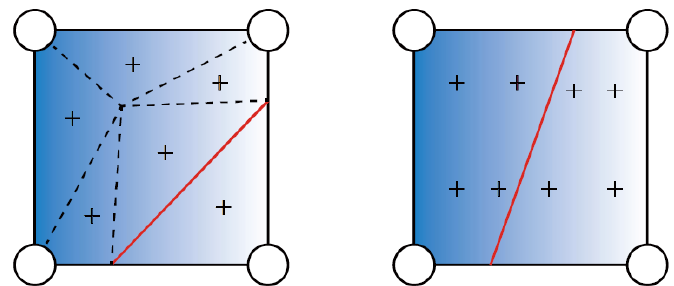
Figure 4. Numerical integration of an enriched element.